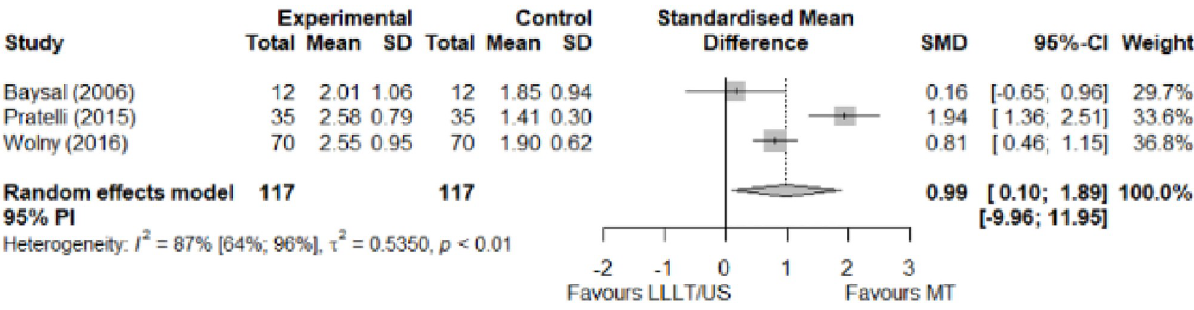
Fig 15. Analysis—Electrophysical modalities versus manual therapy (functional status).